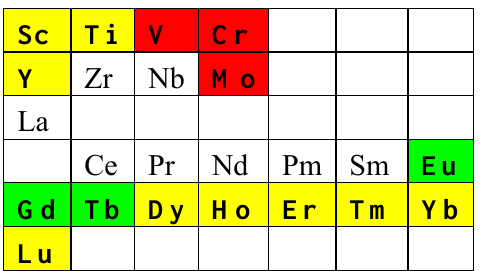
M Cl type compunds and their structures. M on a colored field denominates 3 6 CrCl type; green: Na 3 6